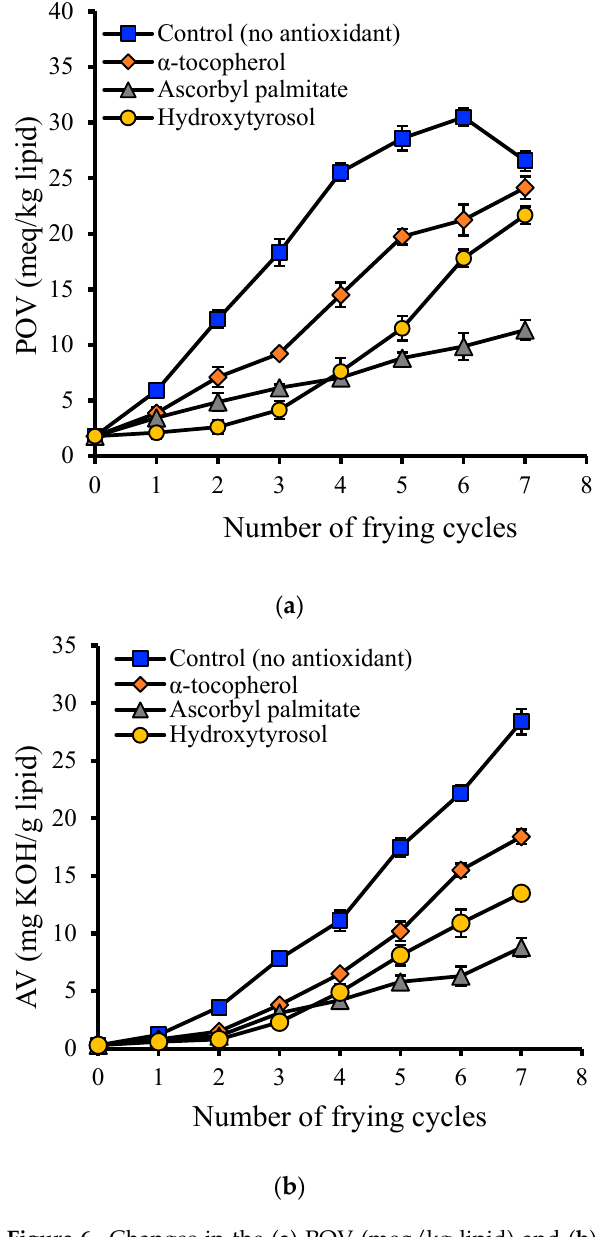
Figure 6. Changes in the ( a ) POV (meq/kg lipid) and ( b ) AV (mg KOH/g lipid) of SFO during repeated deep frying of squid. Results are mean ± SD for triplicate replications.